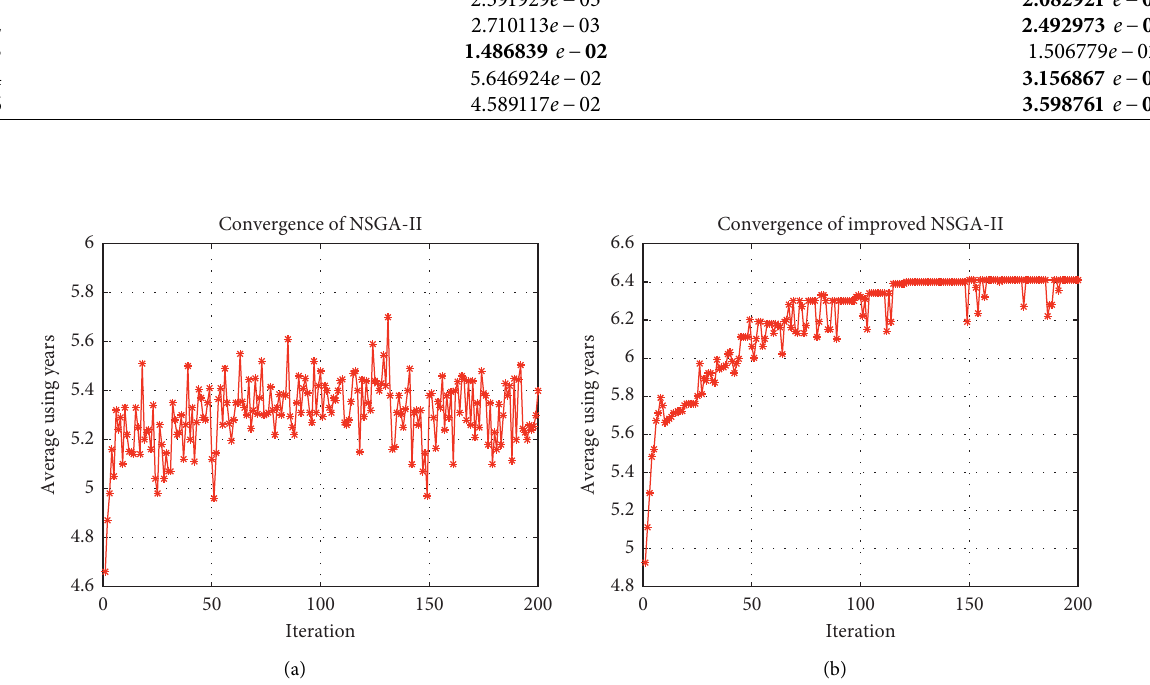
Figure 15: Convergence of the algorithms. (a) Classical NSGA-II. (b) Improved